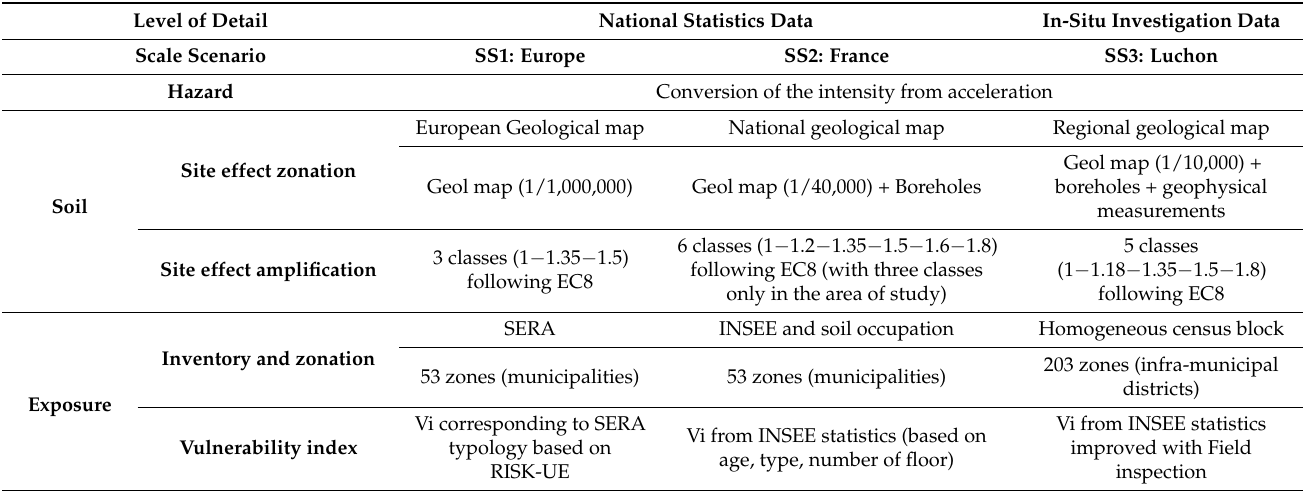
Table 1. Scale scenario description based on the source of databases to characterize the site amplification as well as the building